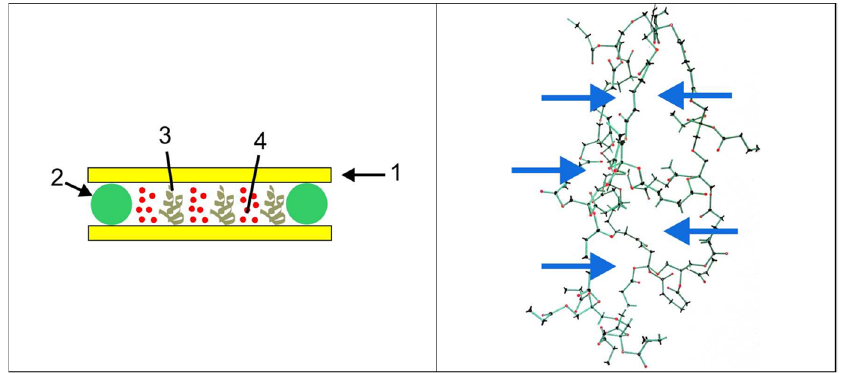
Figure 2. ( Left ) sample structure, 1: glass substrate, 2: microspacers, 3: exposed zones with polymer network, 4: unexposed zones with liquid crystal droplets. ( Right ) 3D polymer network from DPHPA. Arrows show holes in the network with a similar or higher size than an LC molecule.